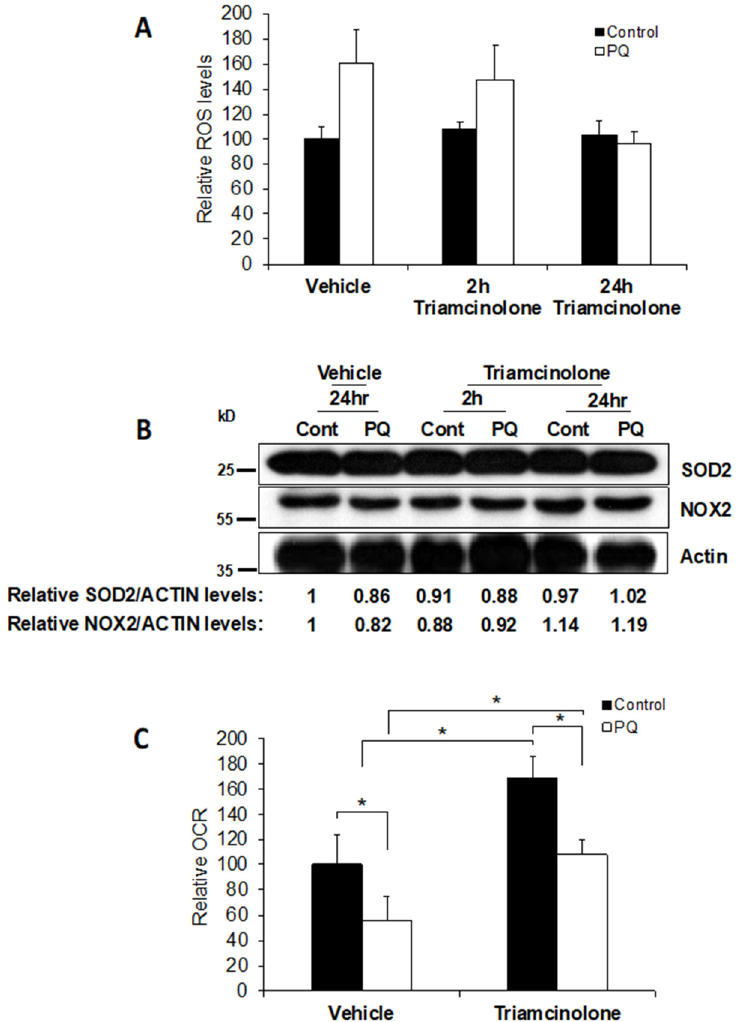
Figure 4. Triamcinolone prevents the increase in ROS through alterations in mitochondrial function. ( A ) Human fibroblasts (1 × 10 5 cells/well in a 12 well plate) were incubated with vehicle or 1 mM triamcinolone for 24 h and were treated with 2 µ M paraquat for 2 h. Cells in the middle group were co-treated with PQ (Paraquat) and triamcinolone for 2 h. ROS levels were measured using the ROS-Glo assay. Error bars on the graph indicate standard deviation from the mean ( n = 2). ( B ) Equal amounts of cell lysates (from pooled samples in A) were separated on an SDS-PAGE gel and probed for SOD2 and NOX2 levels. Actin was probed as loading control. ( C ) Human fibroblasts (2 × 10 4 cells/well) were incubated with vehicle or 1 mM triamcinolone for 24 h and then were treated with 2 µ M paraquat for 2 h. OCR was measured using the Seahorse bioanalyzer. Error bars on the graph indicate standard deviation from mean ( n = 4, * indicates p <